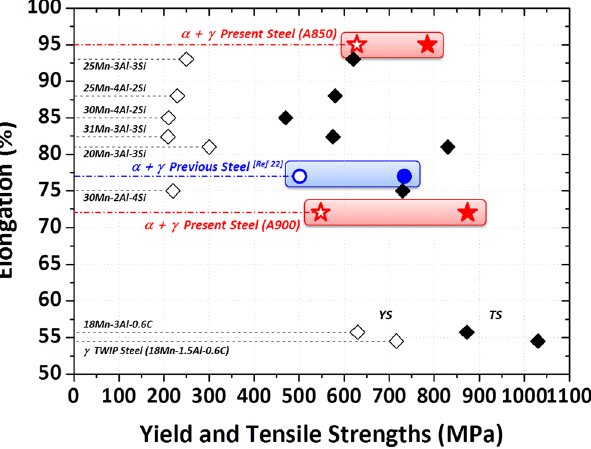
Figure 5. Comparison of room-temperature tensile properties of the present Fe-0.3C-9Mn-5Al duplex lightweight steels with conventional highly-deformable TWIP steels. The typical TWIP steels whose composition is Fe-18Mn-(1.5,3)Al-0.6C show an excellent tensile strength (870~1050 MPa) with relatively low elongation (about 55%) 36 . The TWIP steels containing high-Mn contents of 20~31 wt.% with Si addition